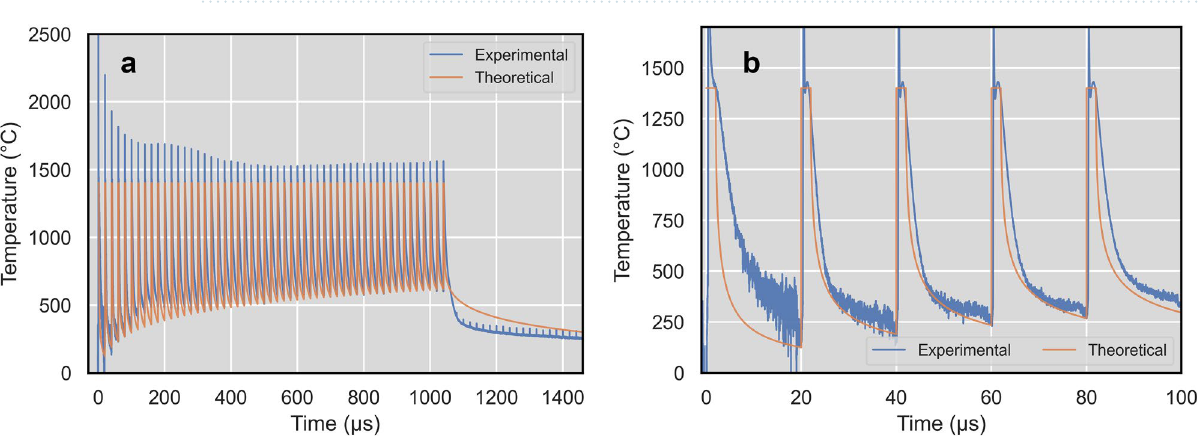
Figure 5. Average heat accumulation ( a ) and phase change plateau length ( b ) in dependance on laser fluence.